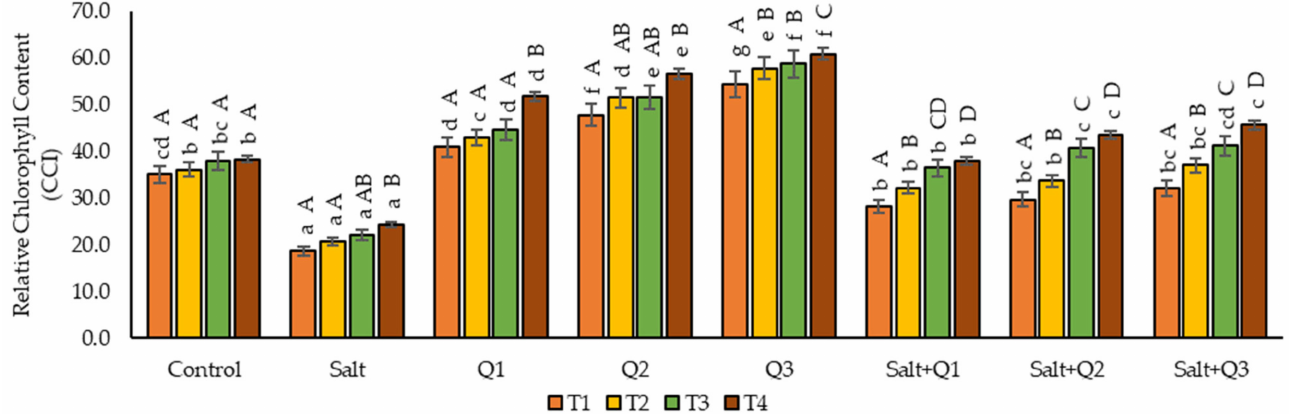
Figure 1. Effect of quercetin–copper complex (Q-Cu (II)) concentrations, salt stress, and terms of measurement on relative chlorophyll content (T1—the first day after the first application, T2—the seventh day after the first application, T3—the first day after the second application, T4—the seventh day after the second application). Capital letters indicate significant differences between the means at measurement terms for each variant of the experiment, lowercase letters indicate significant differences between the means at respective measurement term according to ANOVA followed by Tukey’s HSD test, p =